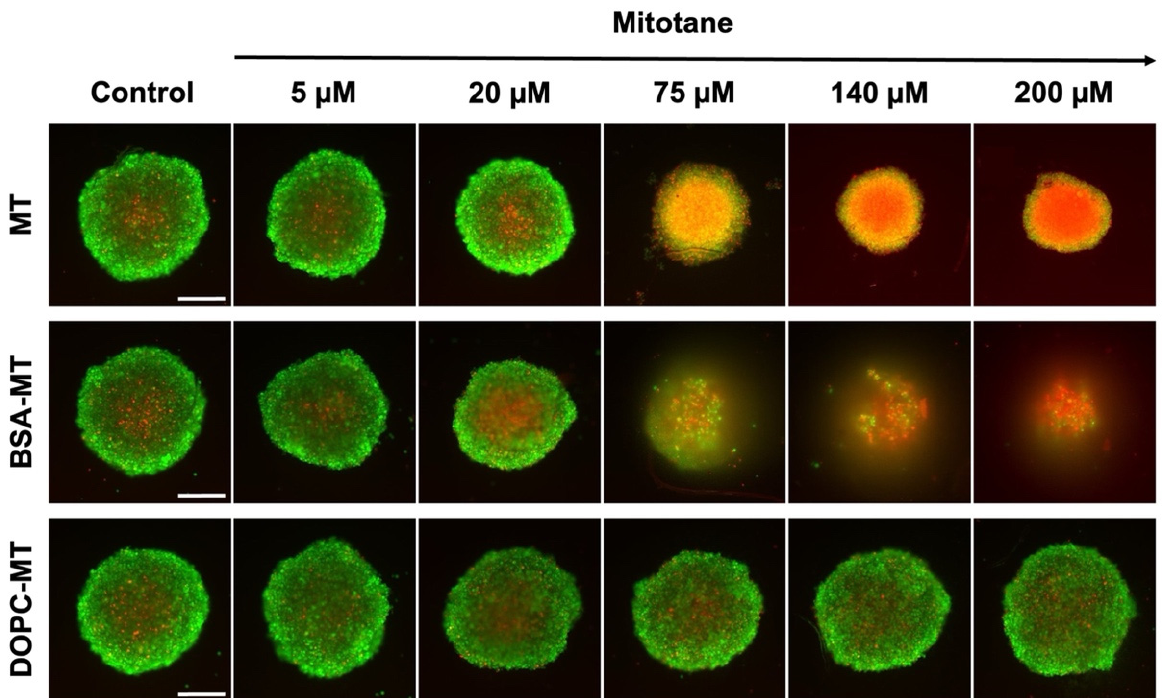
Figure 8. Representative fluorescence microscopy images of NCI-H295R 3D multicellular tumor spheroids based on live/dead staining. Spheroids were treated with free mitotane (MT), albumin- stabilized mitotane (BSA-MT), or liposomal mitotane (DOPC-MT), followed by an incubation period of 72 h. Cells were stained with a combination of calcein-AM (5 µM, green) and propidium iodide (5 µM, red) to visualize viable and dead cells, respectively. Scale bar = 200 µm.